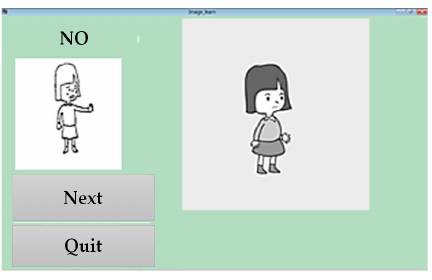
Figure 2. Screenshot of animations on graphic symbol vocabulary.